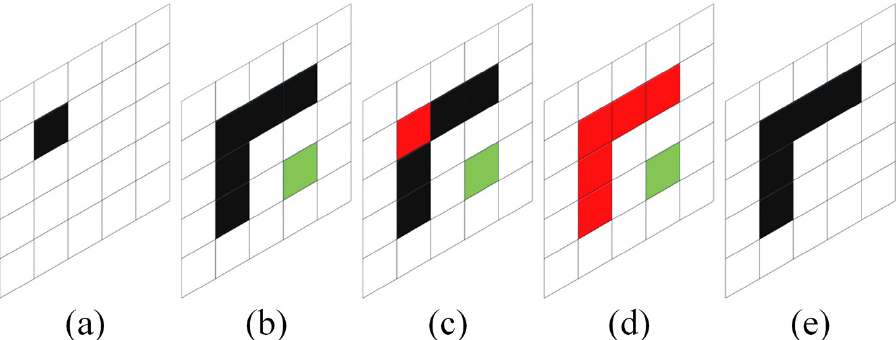
Figure 3. The principle of an improved Canny edge detection algorithm: ( a ) edge detection result under a high threshold; ( b ) edge detection result under a low threshold; ( c ) edge detection result after initial activation; ( d ) edge detection result after multiple activations; ( e ) final edge detection result.